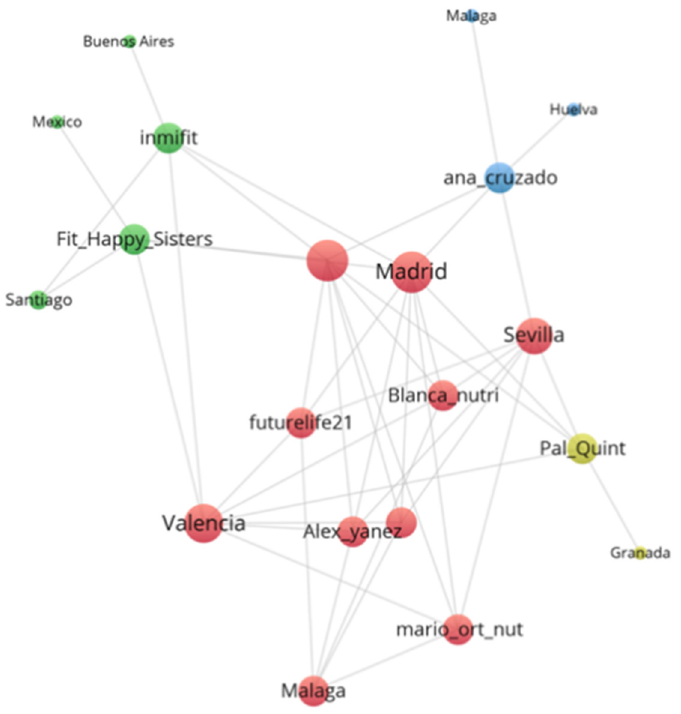
Figure 2. Audience concentration network by city .